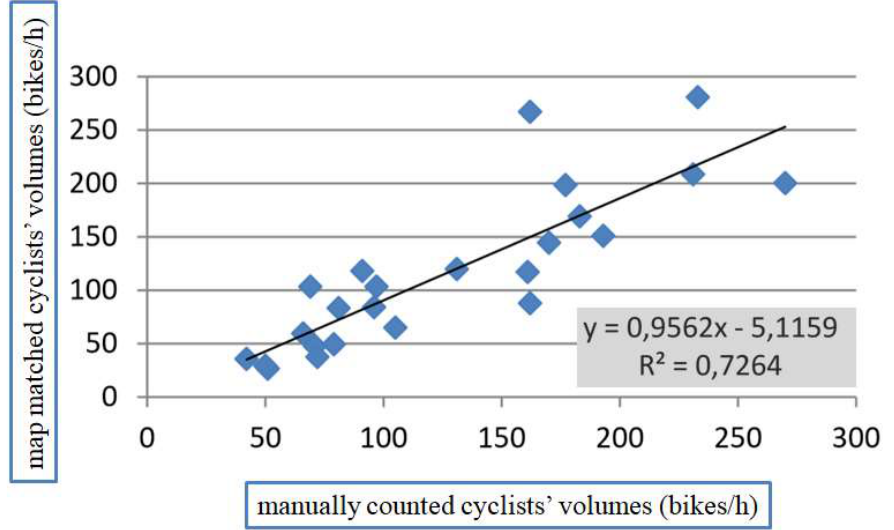
Figure 6. Regression function between manually counted cyclists’ volumes and map matched cyclists’ volumes (May 2016).